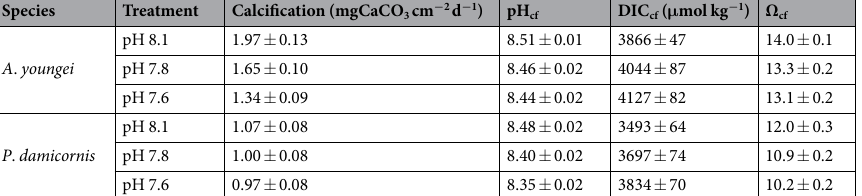
Species Treatment